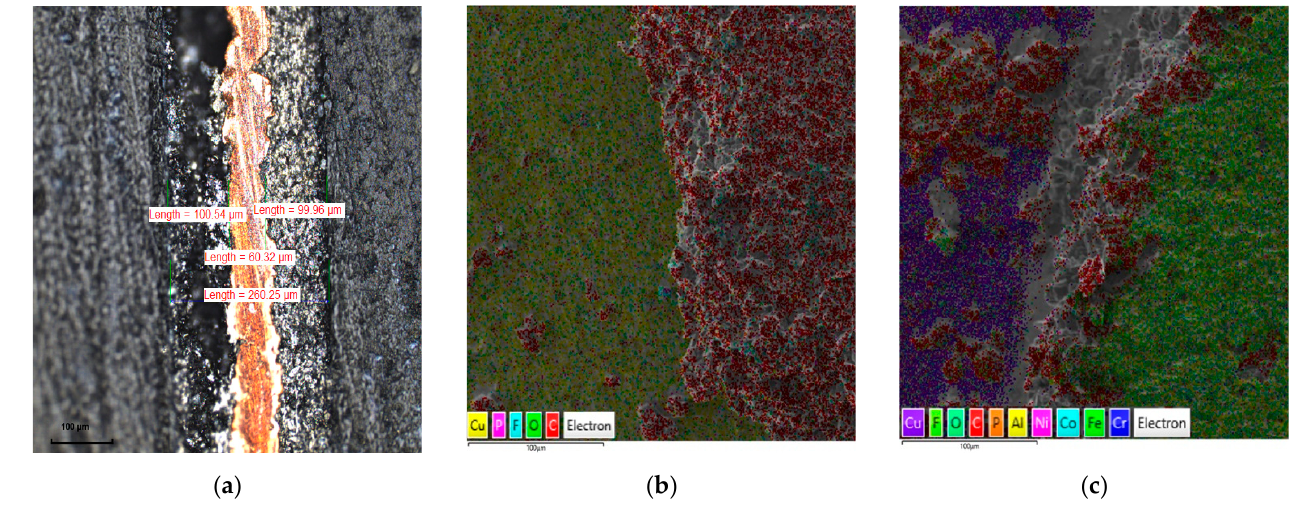
The entire carbon bilayer deposited on a Cu (anode) is around 100 μ m thicker than 227 the layer of cathode materials (it measures 260 μ m in total). The Cu foil has an average of 228 60 μ m, with each spinel layer 100 μ m thick. A detail of the active material thickness is 229 shown in Figure 5 (a).